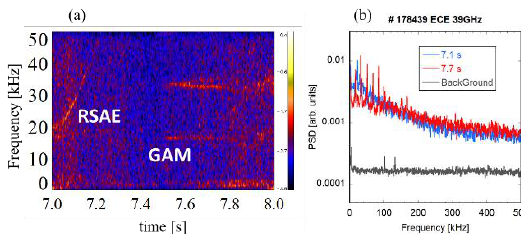
Fig. 14. Examples of RSAE and GAM oscillation observations. (a) Spectrogram, and (b) frequency spectra of two timings. The gray line is the estimated background noise for this